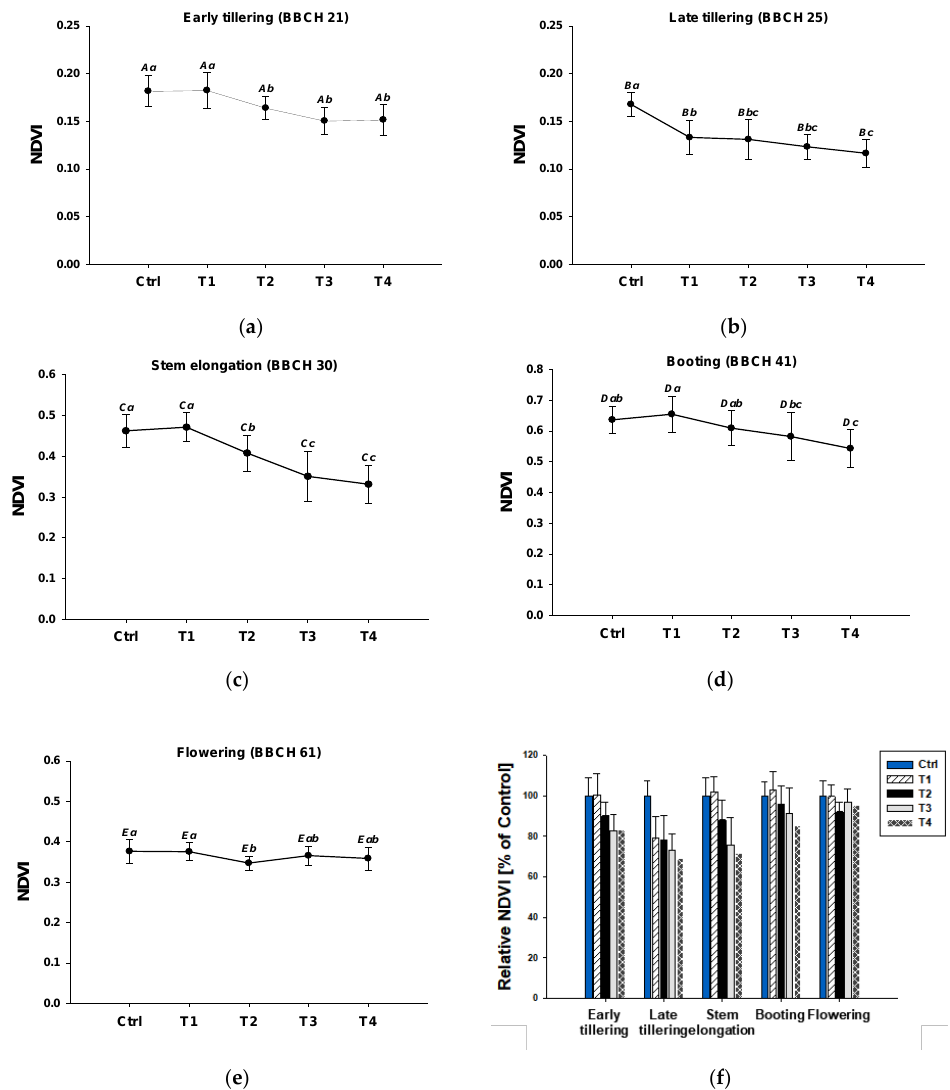
Figure 5. Normalized difference vegetation index (NDVI)-based damage assessment of rice after toluene exposure at ( a ) early tillering stage (ET); ( b ) late tillering stage (LT); ( c ) stem elongation stage (SE); ( d ) booting stage (B); ( e ) flowering stage (F). The same capital letters refer to the same growth stages. The small letters refer to the significant differences in the mean NDVI among the control and four toluene-exposed rice (α = 0.05). ( f ) shows the relative mean NDVI of toluene- exposed rice at each growth stage, which is expressed as the proportion to the control group (100% of the control group).